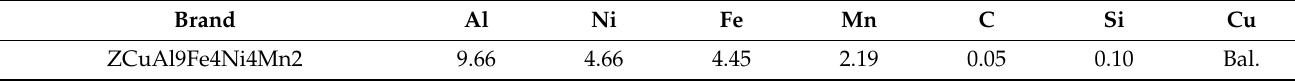
Table 1. Chemical composition (wt.%) of the investigated